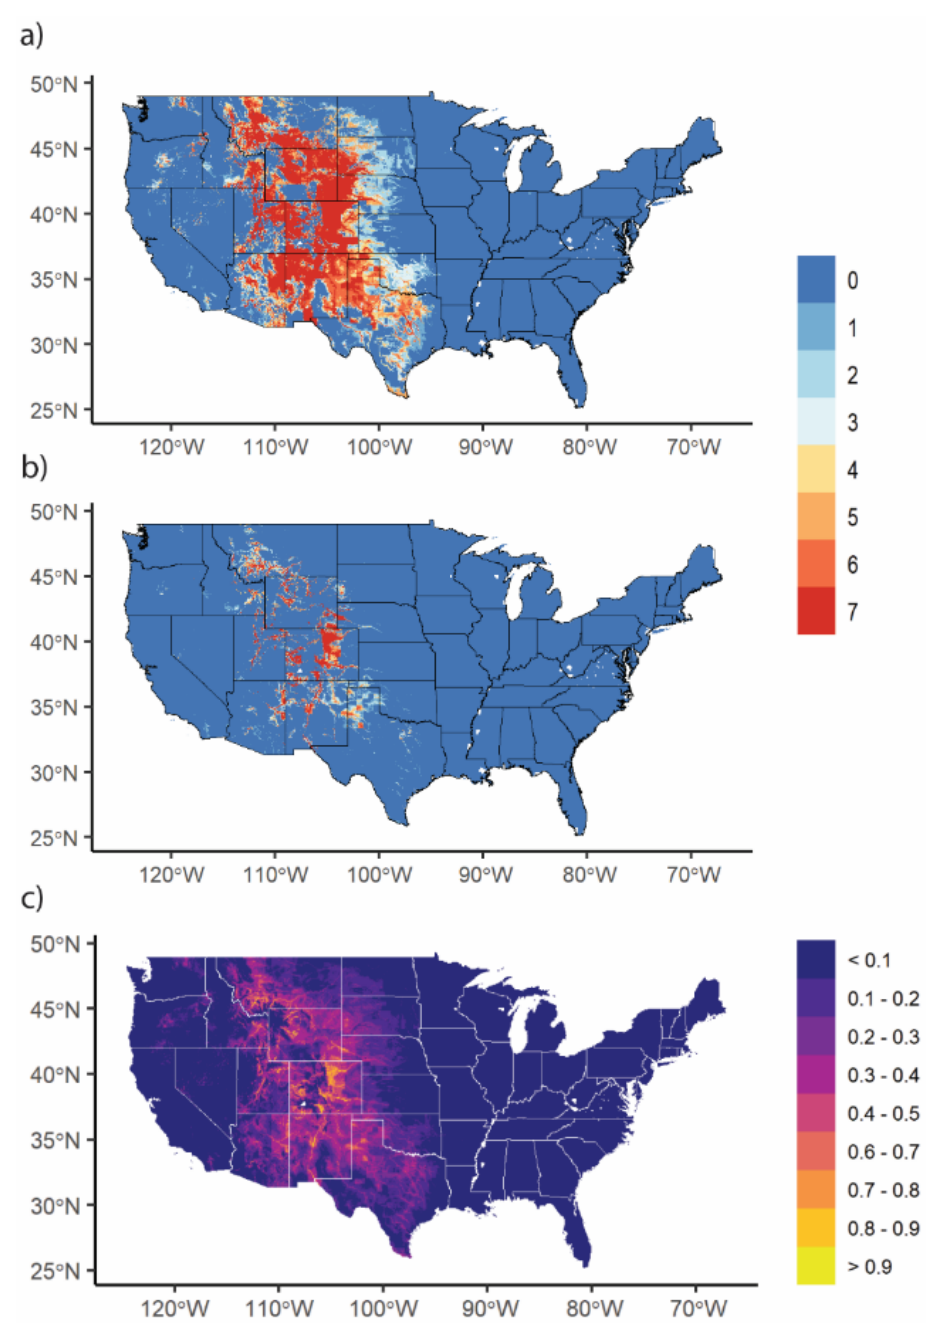
Figure 8. As Figure 6, except using climate projections from the RCP 8.5 emission scenario. The agreement between GCMs shown as the number of models (out of 7 total) for RCP 8.5 projections that have ROR ( a ) greater than 0.2 and ( b ) greater than 0.5. The averaged MaxEnt estimated occurrence of all GCMs for projected climate scenario RCP 4.5 is shown in panel ( c ).